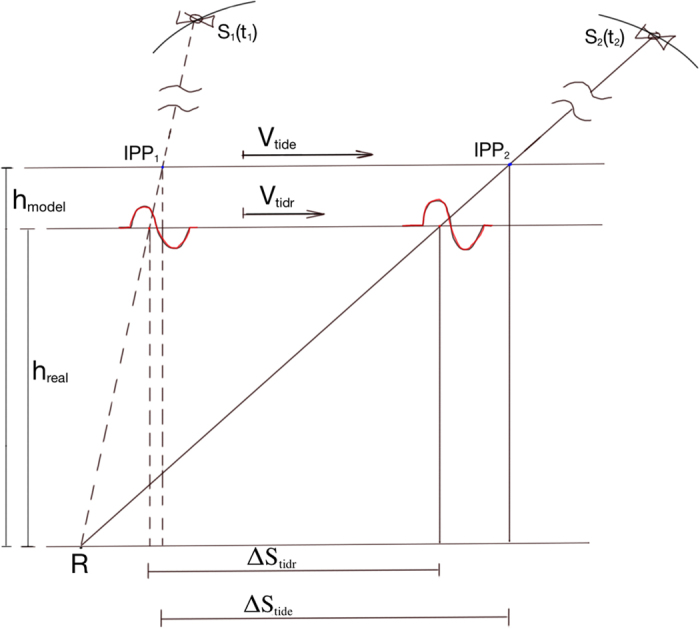
Schematic representation of the TID detection at t1 and t2 = t1 + Δt by two different satellites S1 and S2.R represents the receiver, hmodel and hreal represent the modeled ionospheric layer and the real ionospheric layer. In this case the two layers are located at 300 and 350 km, respectively.